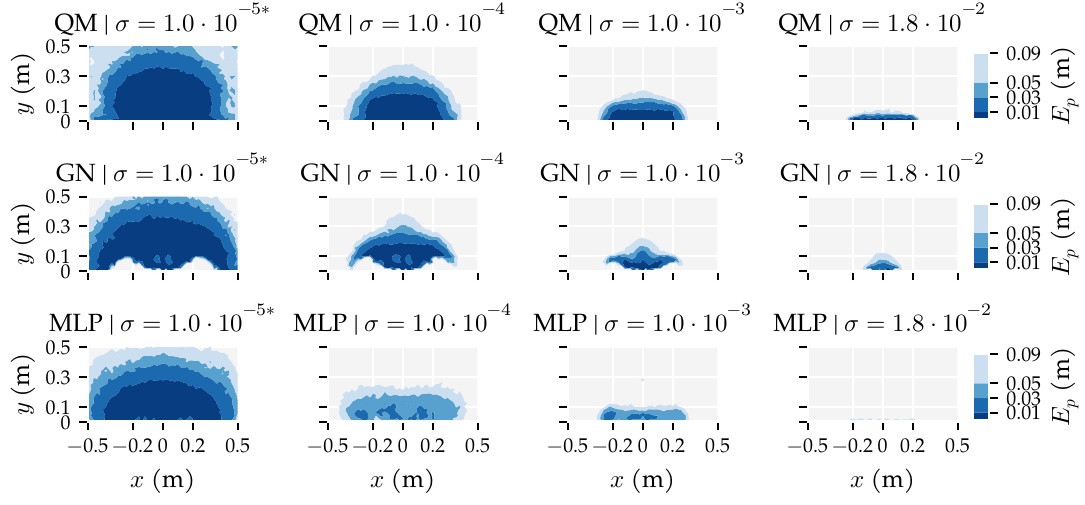
Figure A12. An overview of the movement direction error E (cid:118) (Equation (5)) of QM, GN, and MLP using simulated sensors with higher velocity equivalent noise levels. ( a ) Total areas with a median movement direction error E ϕ below 1cm, 3cm, 5cm, and 9cm. ( b ) Boxplots of the movement direction error distributions, whiskers indicate the 5th and 95th percentiles of the distributions. Predictions with errors outside these percentiles are shown individually. The values for σ = 1.0 × 10 − 5 ms − 1 are based on the D s = 0.01 condition in Analysis Method 1. The (x + y) sensor configuration was used. The MLP was re-trained for each noise level. Both the MLP and GN used the optimal hyperparameter values from the D s = 0.01 condition of Analysis Method 1.